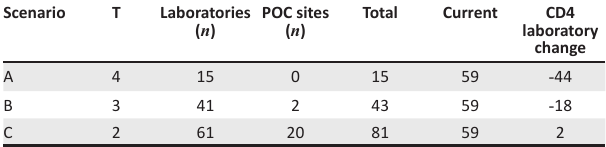
T, travel time; POC, point of